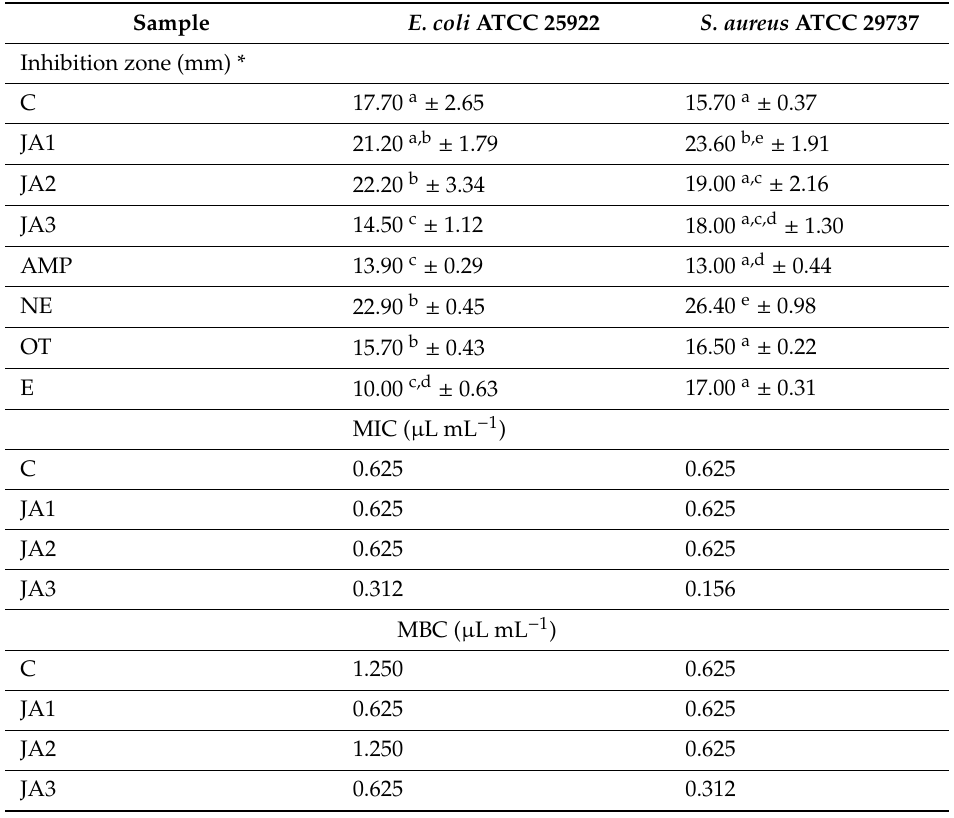
Table 3. E ff ect of jasmonic acid elicitation on antimicrobial activity of essential oil from basil.